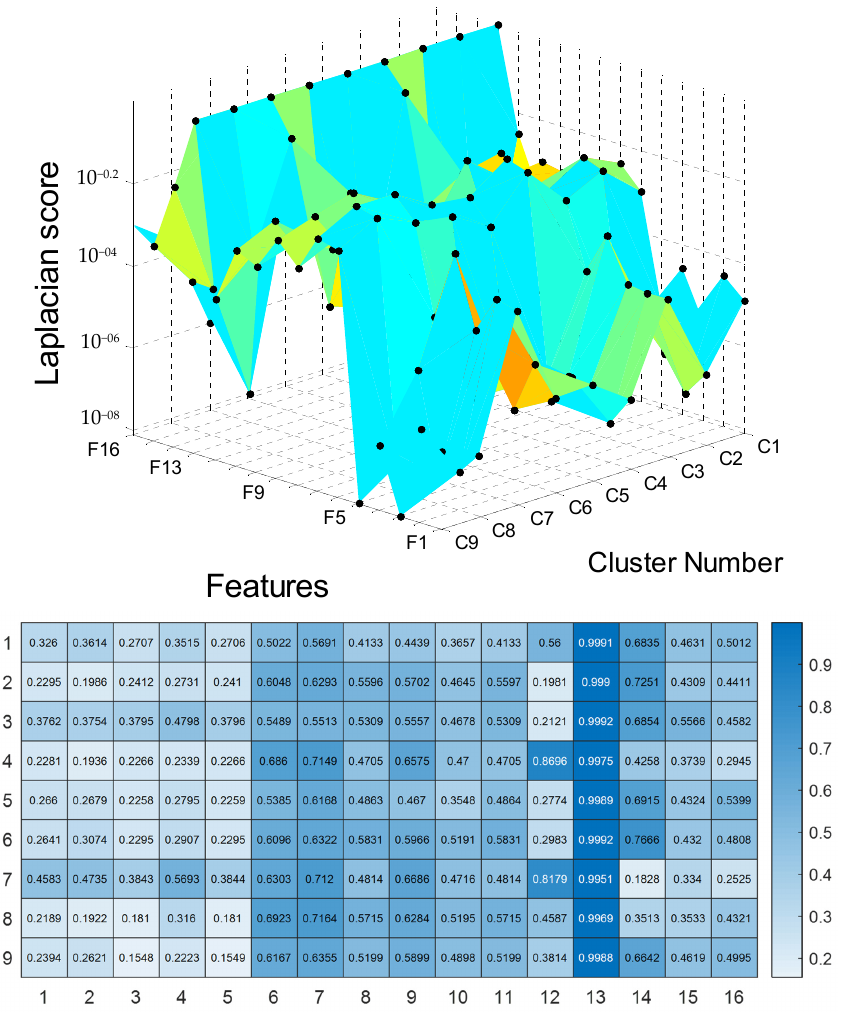
Figure 4. The results for Laplacian score.